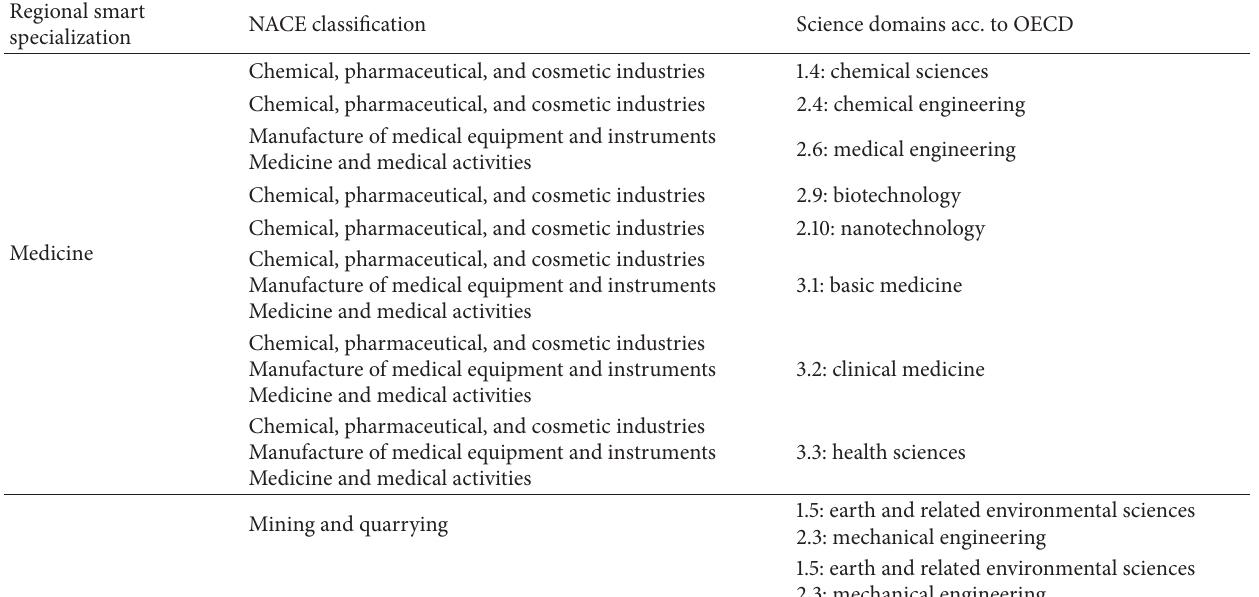
Table 6: Science domains contributing to the more effective economic development related to the regional smart specialization in medicine, power engineering, and ICT (the sixth